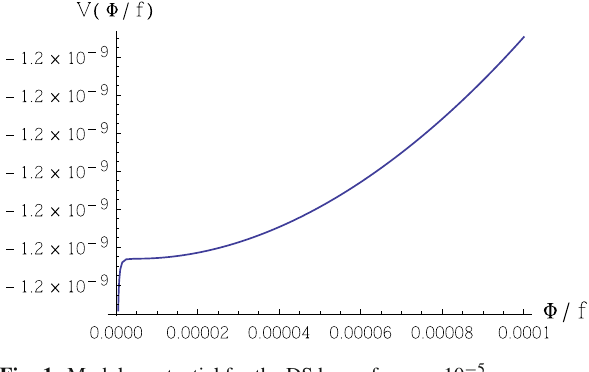
Fig. 1 Modular potential for the DS brane for ω = 10 − 5